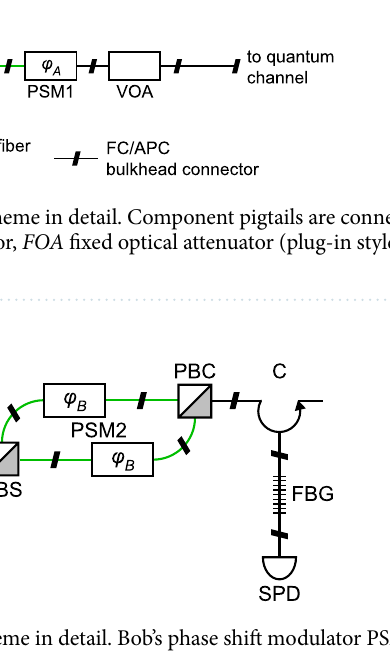
Figure 3. Bob’s optical scheme in detail. Bob’s phase shift modulator PSM2 is polarization-insensitive and is implemented as two identical modulators acting on orthogonal components of input polarization. PBS fiber- optic polarization beam splitter, PBC fiber-optic polarization beam combiner, C circulator, FBG fiber Bragg